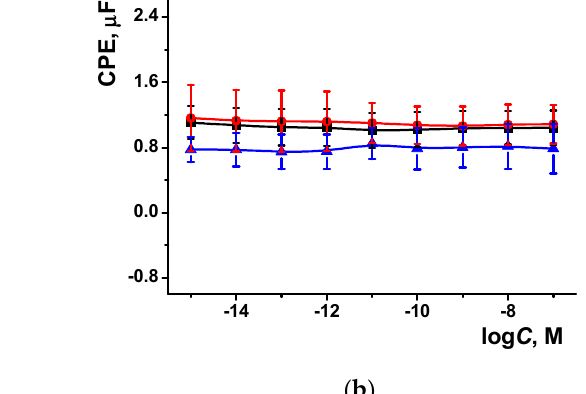
Figure 12. ( a ) Charge transfer resistance, and ( b ) constant phase element dependence on idarubicin concentration in standard solution (black), in Zavedos ® medical preparation (red), in artificial mixture of idarubicin standard solution and lactose monohydrate (blue) on PAB-2/DNA-MB, EIS, 0.1 M HEPES buffer containing 0.03 M NaCl, pH 7.0 in presence of equimolar mixture of 0.01 M [Fe(CN) 6 ] 3 − and [Fe(CN) 6 ] 4 − ions. Results are mean ± S.D. obtained in 6 independent experiments. Typical Nyquist diagrams obtained after the incubation of the biosensor in idarubicin standard solution (black), Zavedos ® medical preparation (red), and an artificial mixture of idarubicin standard solution and lactose monohydrate (blue) are presented in Figure 13.